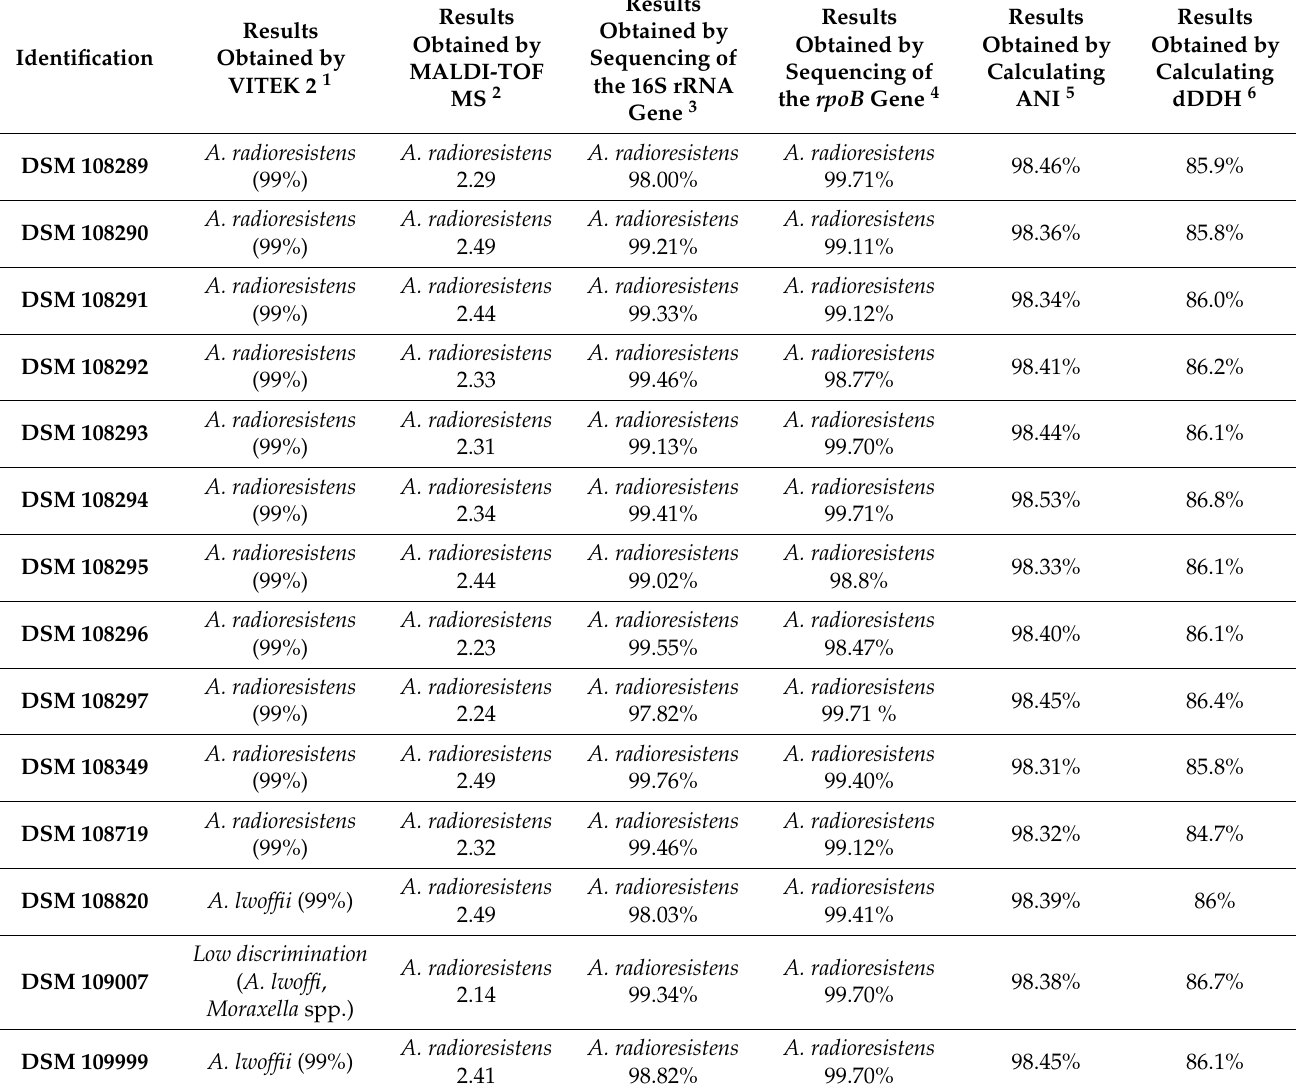
Table 4. Comparative overview of the applied diagnostic